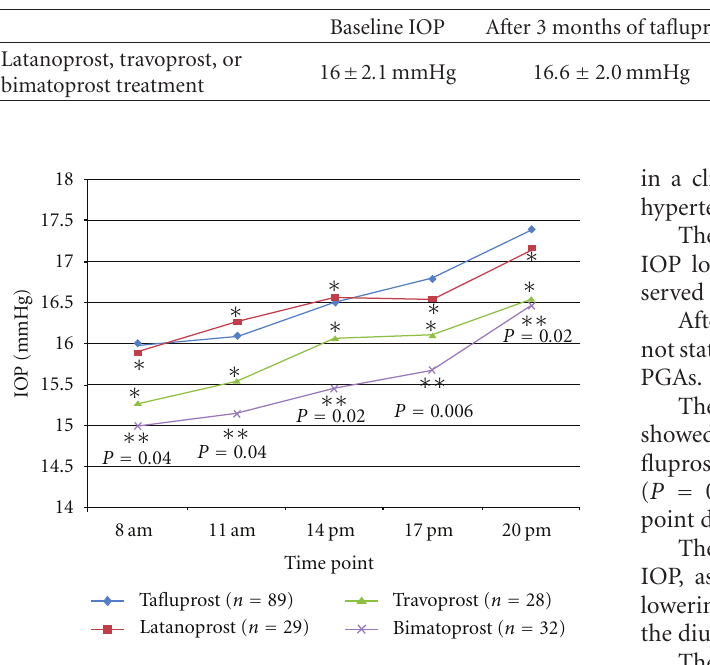
Figure 2: Graph showing IOP at each time point of the daily curve of each drug group. ∗ P > 0 . 05 from the comparison of tafluprost time point with the corresponding latanoprost and travoprost time point. ∗∗ Values from the comparison between tafluprost and bimatoprost of each time point of the daily curve. (Curve of lat- anoprost, travoprost, and bimatoprost are prestudy, whereas curve of tafluprost is after